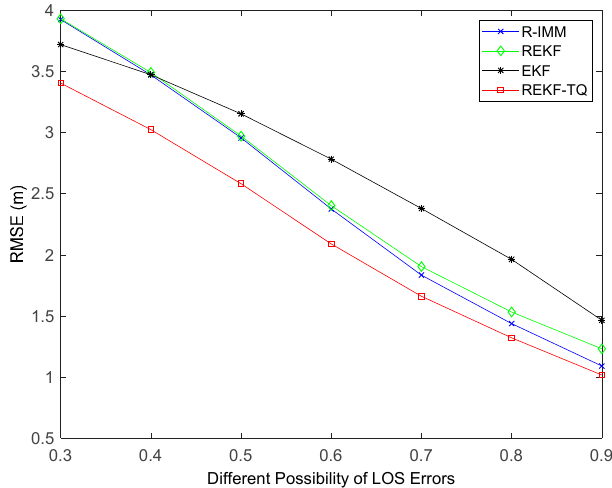
Figure 7. The RMSE versus standard deviation of NLOS errors.